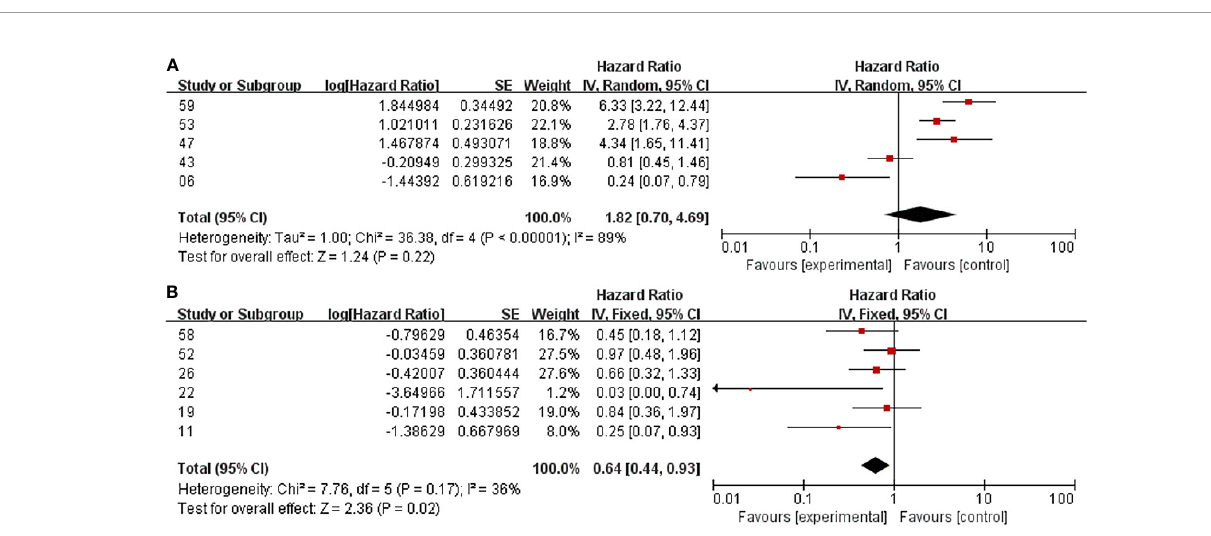
FIGURE 6 | Subgroup analysis. GTR+RT vs GTR, PFS, GTR= Simpson Grade I or II tumor resection (A) . GTR+RT vs GTR, PFS, GTR= Simpson Grade I, II or III tumor resection (B) .